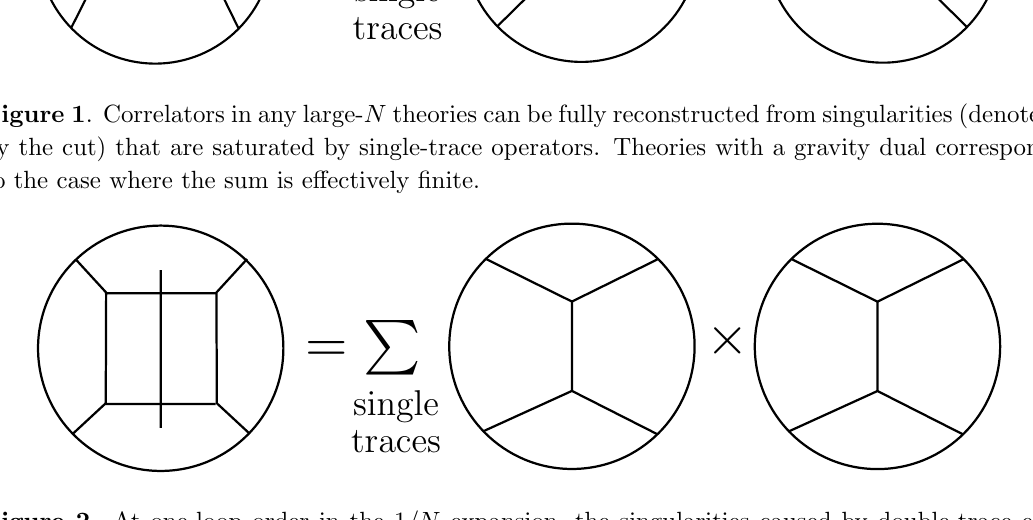
Figure 2 . At one-loop order in the 1 =N expansion, the singularities caused by double-trace ex- changes are equal to products of single-trace tree